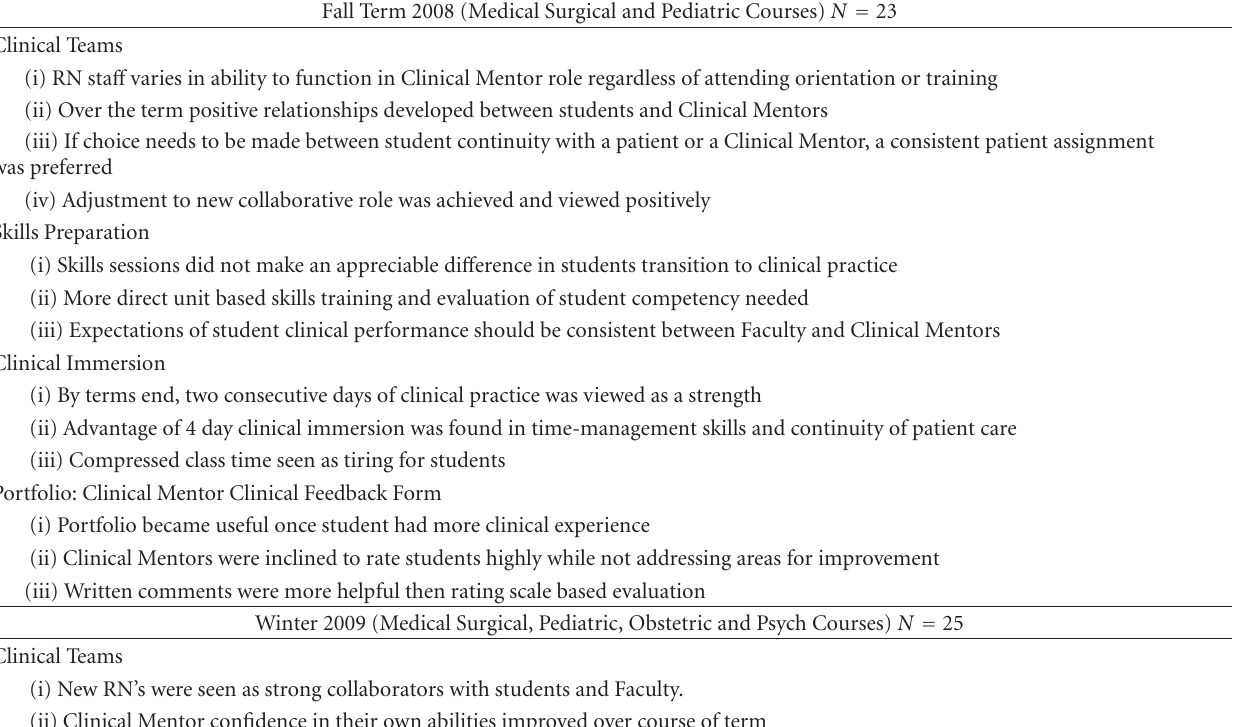
Table 3: Pilot faculty and clinical sta ff discussion group